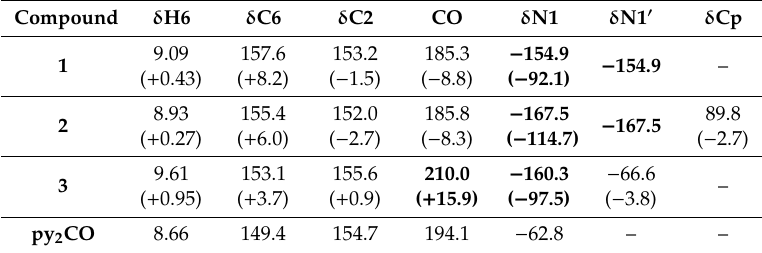
Table 4. 1 H, 13 C and 15 N NMR chemical shifts of 1 – 3 complexes in DMSO-d 6 . The coordination shifts are shown in parentheses